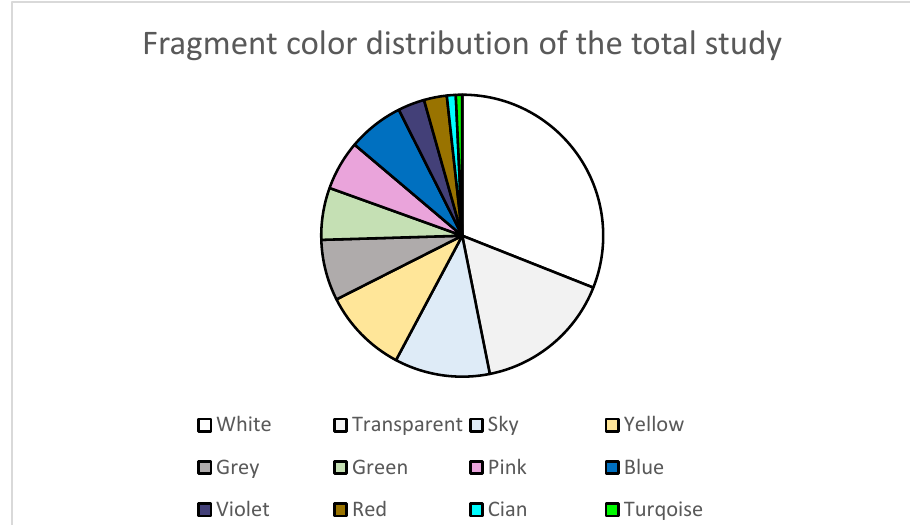
Figure 2. Fragments color distribution of the total study (n = 687).